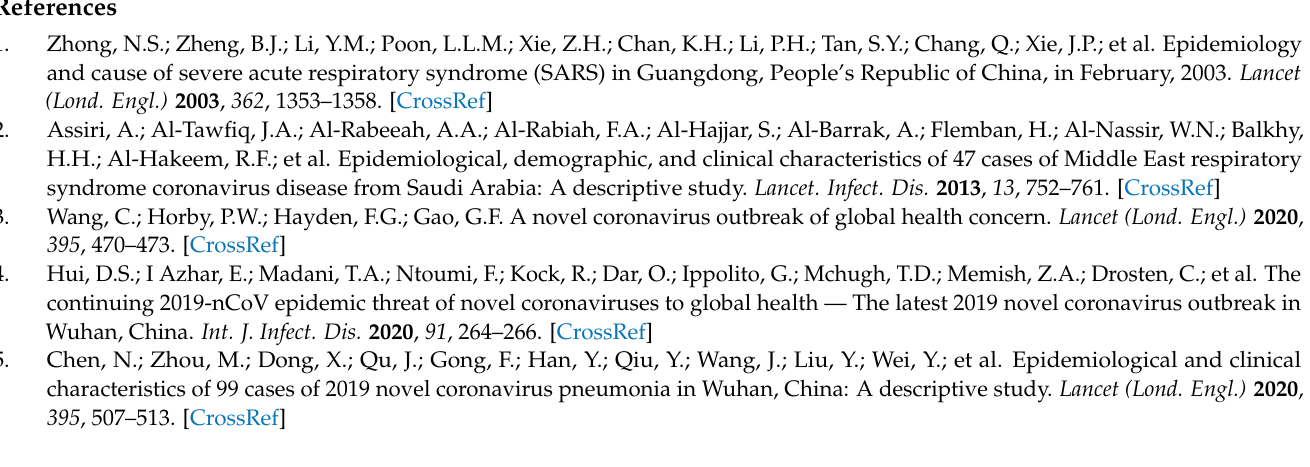
Figure S1: mRNA expression of RELA , NFKB1 , and NFKBIA genes in monocytes cul- tured in the presence of 1 µ g/mL SARS-CoV-2 proteins S (spike) and N (nucleocapsid) for 3 days; Figure S2: mRNA expression of RELA , NFKB1 , and NFKBIA genes in monocytes differentiated to- wards macrophages in the presence of 1 µ g/mL SARS-CoV-2 proteins S (spike) and N